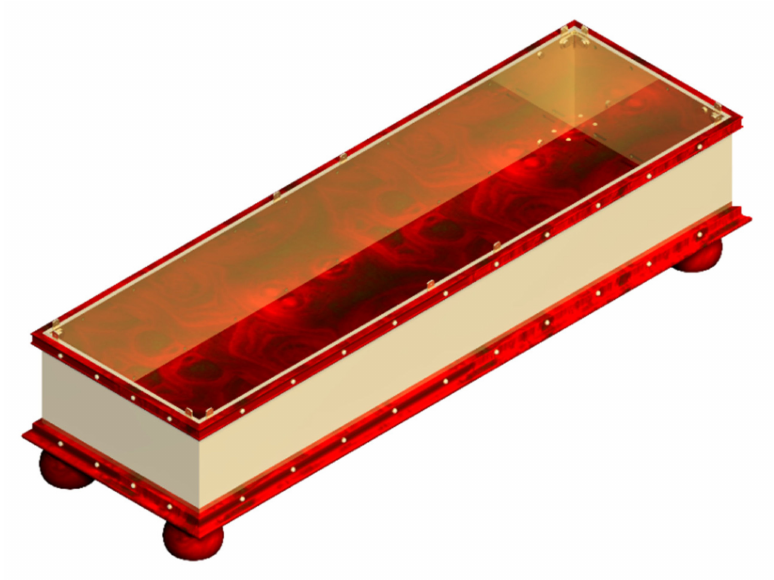
Figure 17. Assembled panels, base, edges and feet.